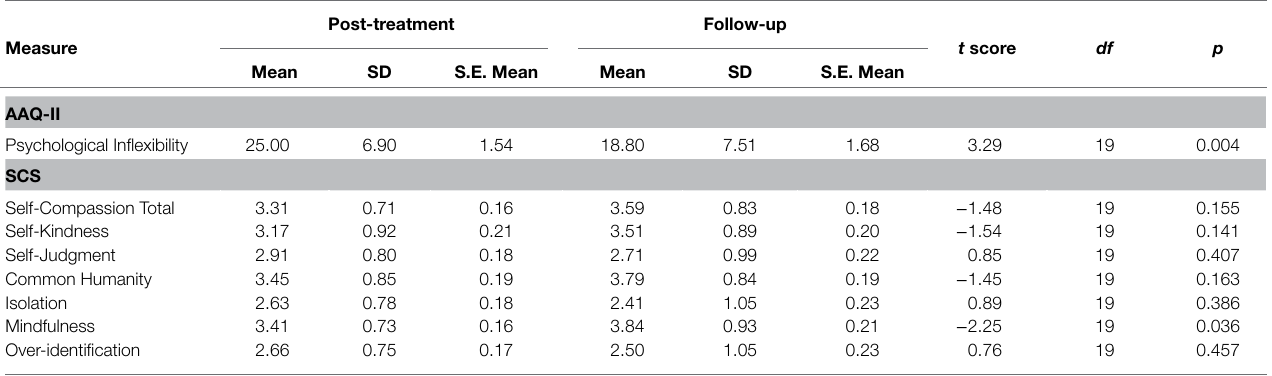
TABLE 4 | Paired sample t-test: Sleeper effect for psychological inflexibility and self-compassion.